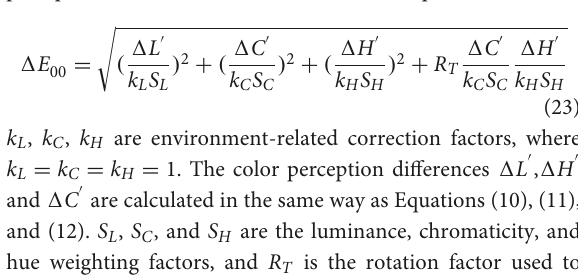
CIEDE2000 color difference is (cid:49) E and similar to that of LAB 00 color difference, but some improvements based on subjective visual perception experiments are carried out to establish a linear relationship between the changes of lightness, hue, saturation, and visual perception, which is considered to be the best uniform color difference model in line with subjective visual perception, and its calculation formula is as Equation (22).